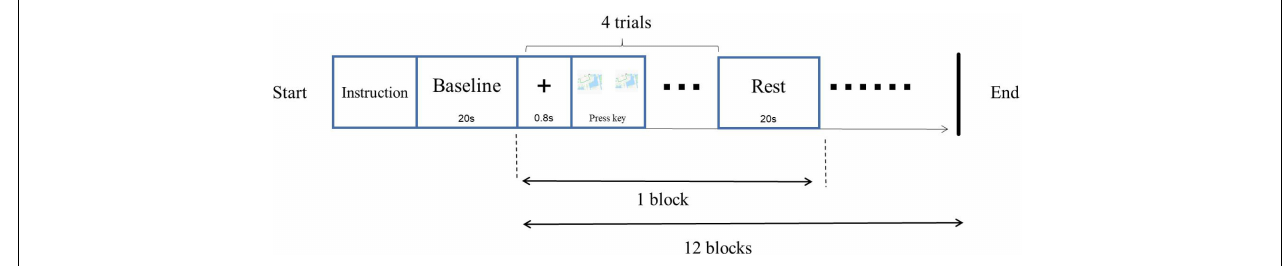
FIGURE 2 | Experimental procedure of object mental rotation.